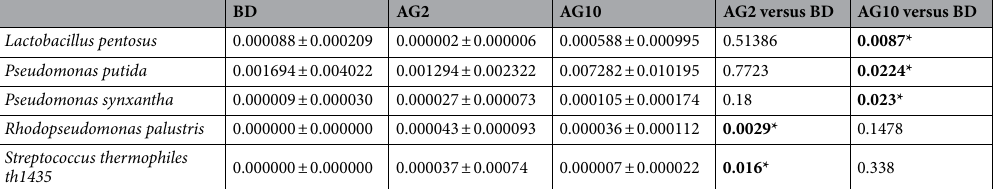
Table 3. Over-abundant probiotic species among diets for hepatopancreas samples. AG2 versus BD and AG10 versus BD columns represent the p -value obtained with a Wilcoxon test for each comparisson. The values represent means (± S.D). *Indicates significant p-values <0.05. Significant values are in bold.